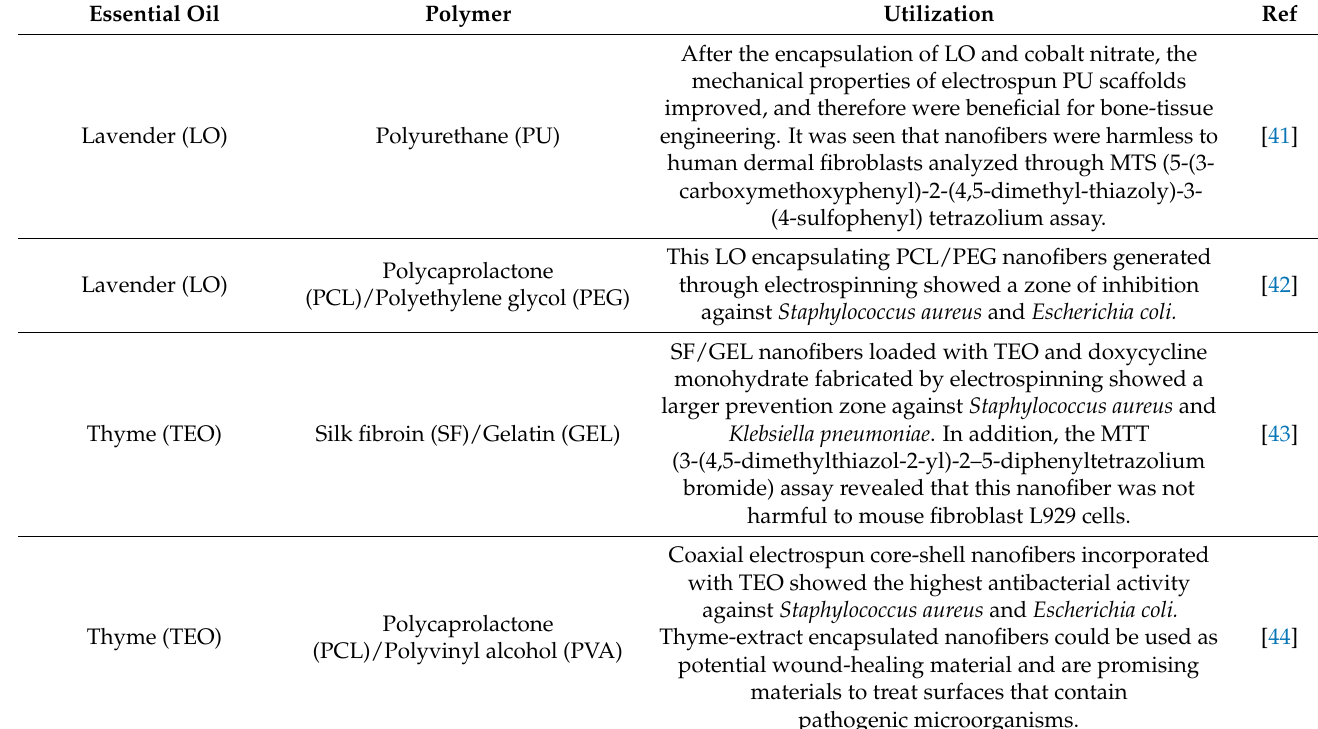
Figure 1. Different applications of fabricated nanofibers in cosmetics, drug delivery, the food industry, wound healing, and hard-tissue engineering. Table 1. Nanofiber-incorporated essential oils for diverse